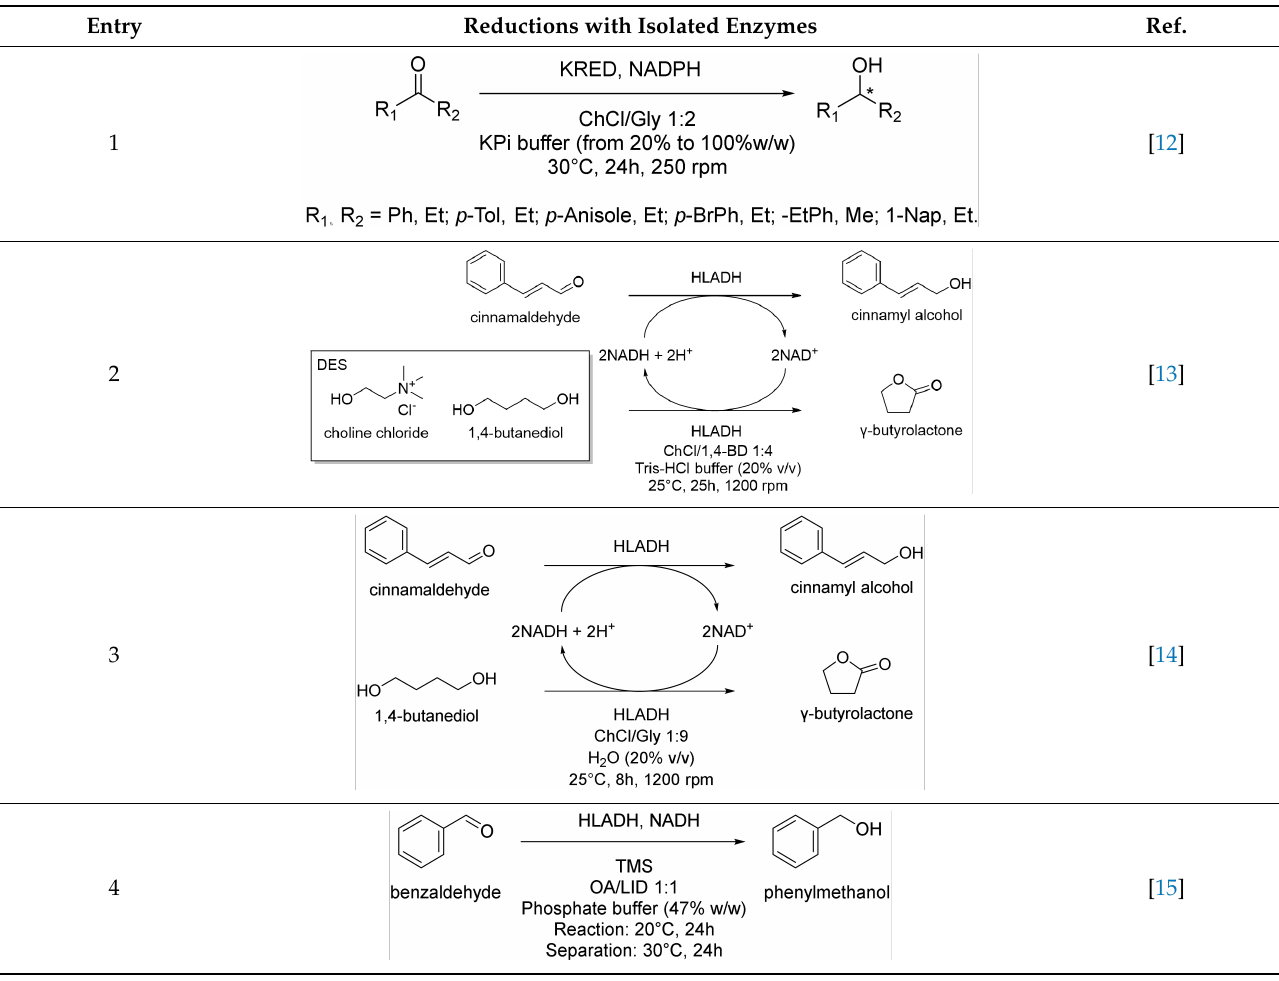
Table 1. Reductions with isolated enzymes. Entry Reductions with Isolated Enzymes